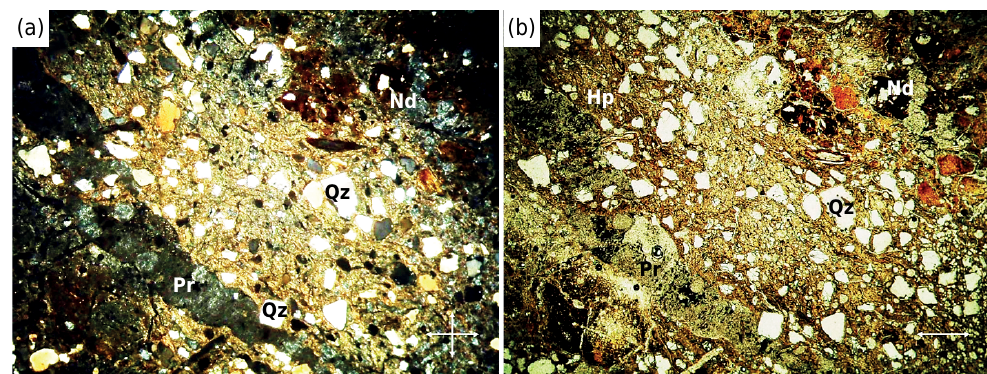
Figure 6. Photomicrographs images of Cgnz2 layer in the Solonchak profile [(a): cross-polarized light; (b): natural light]. Presence of quartz (Qz) and nodule (Nd) in the groundmass. Features of hypo-coating (Hp) probably iron and, or, manganese in the pores